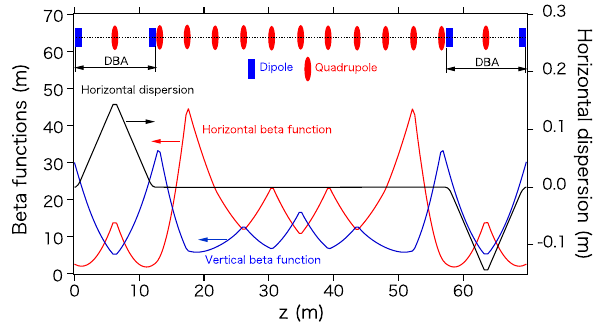
FIG. 2. Beam optics functions and magnet configuration of the BL2 dogleg beam transport. The red and blue lines show horizontal and vertical beta functions and the black line is a horizontal dispersion function.